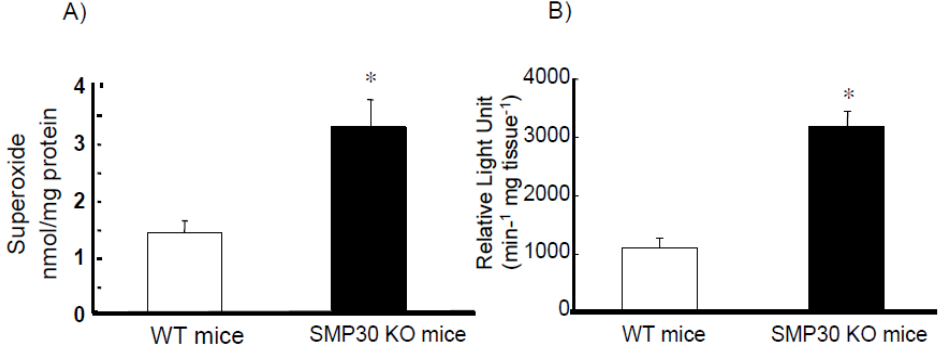
Figure 2. Effect of SMP30 deficiency on generation of superoxide and activity of NADPH oxidase in cardiac myocytes under electrical stimulation. Generation of superoxide ( A ) was measured by HPLC. NADPH oxidase activity was measured by lucigenin luminescence; ( B ) The levels of superoxide and NADPH oxidase activity were greater in SMP30 KO mice compared to WT mice under electrical stimulation. Values were expressed as the mean ± S.E.M. * p < 0.01 vs. without agents. n = 8,